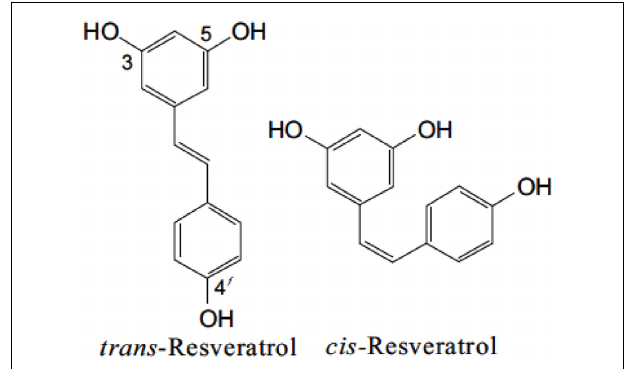
FIGURE 1 | Isomers of resveratrol. Chemical structures of trans and cis -resveratrol.